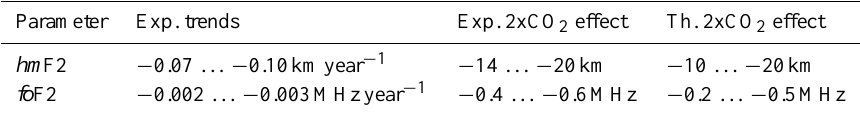
Table 3. Collection of experimental trends from the right column of Table 2, extrapolated experimental effects for CO 2 doubling, and model results for doubling of the CO 2 . For details see